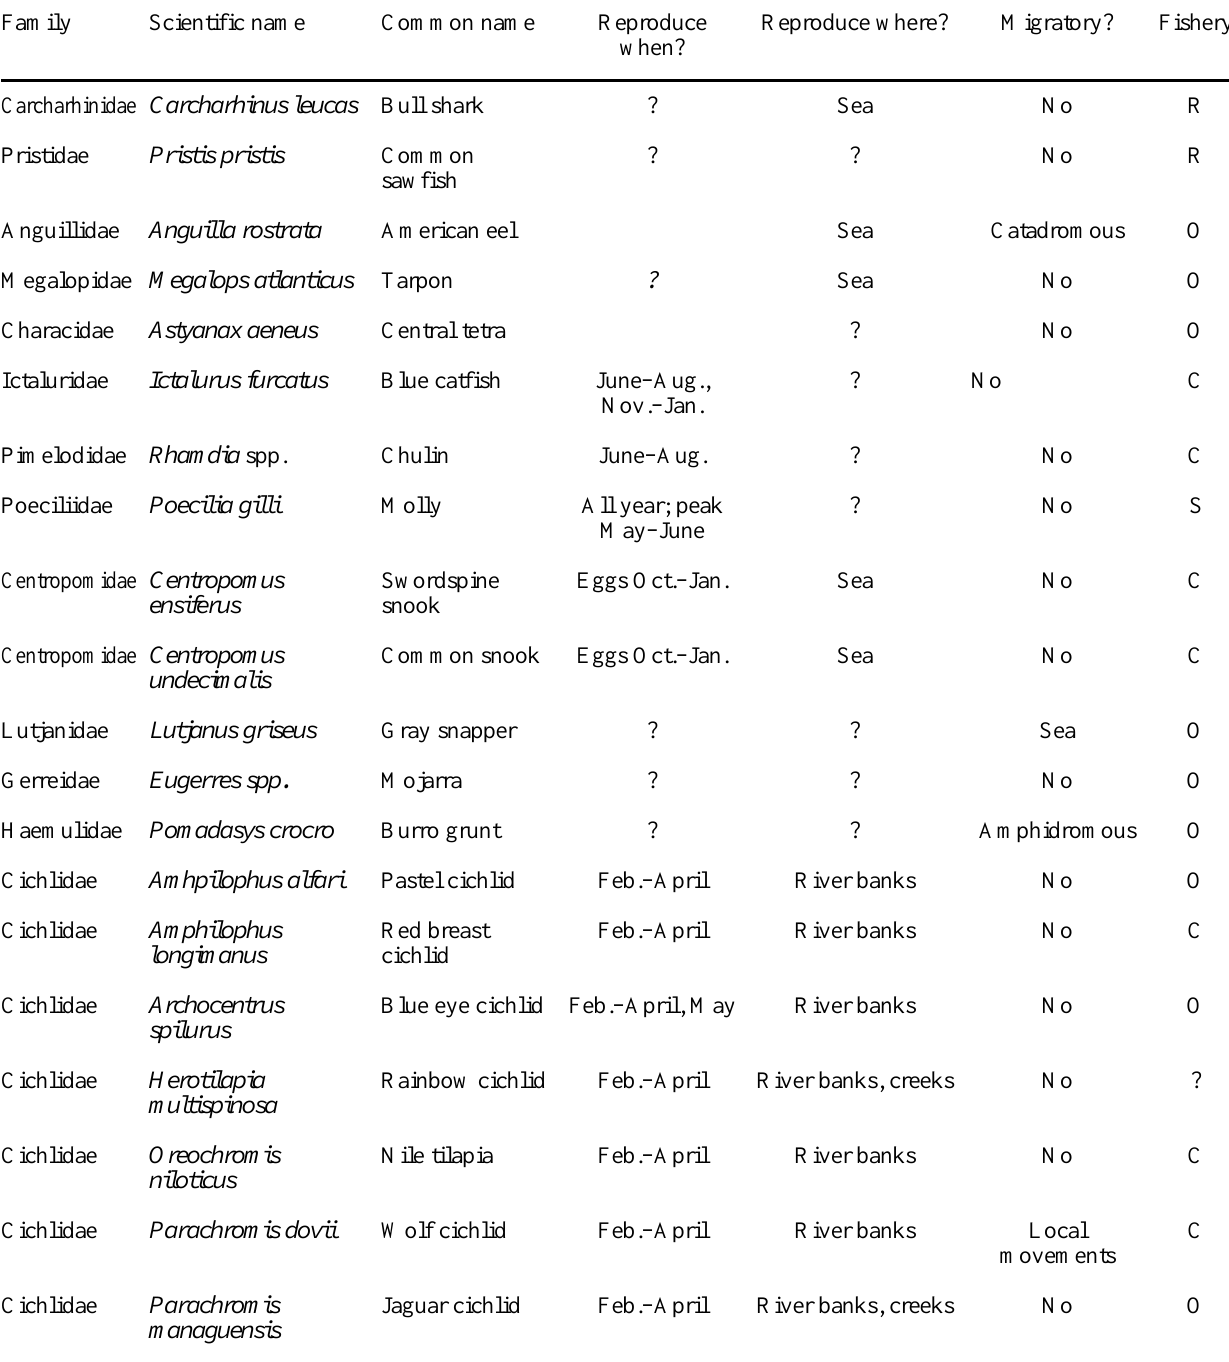
Table 2. Fish species and some of the other aquatic organisms reported by the fishermen interviewed, with information on their reproductive habits, migratory status, and importance to local fisheries. Fisheries codes are: rarely captured (R), occasionally captured (O), seasonally important (S), and commonly captured